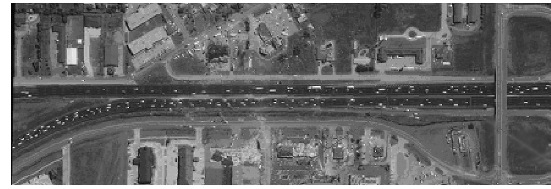
Figure 6: SPOT-5 Panchromatic Image (2.5m)